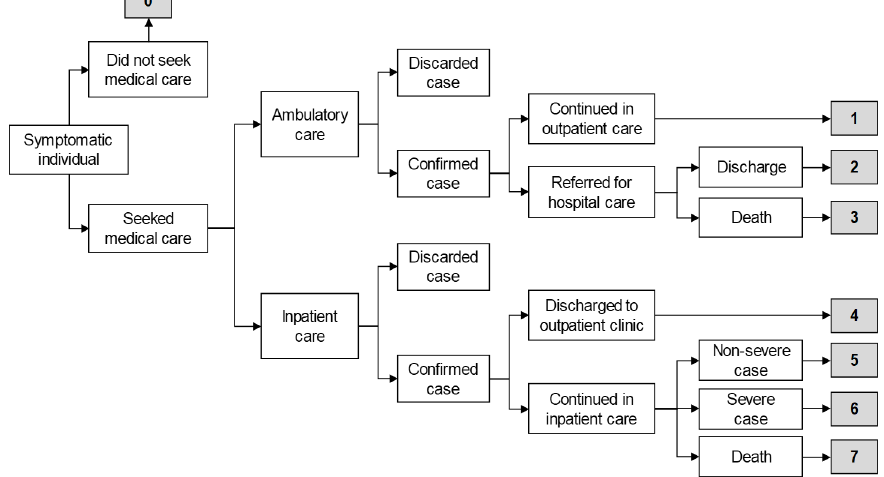
Figure 1. Decision tree for case classification [29]. For details see section: 2.1 Case Classifications . Table 1 details the assumptions made for clinical management of cases for each sce- nario; they were defined according to the National Clinical Guidelines for the Prevention, Diagnosis, and Treatment of Seasonal Influenza in Mexico, as follows [30]: Table 1. Clinical management by scenarios. No Medical Care X 1 Data represent the number of consultations. 2 Data represent the number of prescriptions, units purchased (over-the- counter medications), or culture tests ordered. 3 Estimation of the indicator (years of life lost) applies only to the popula- tions in the scenarios indicated by X. Abbreviations: ER, emergency room; PCR, polymerase chain reaction. 2.2. Laboratory Diagnosis Confirmation of influenza is based on real-time PCR results. In ambulatory care, sam- ple collection for confirmation is required for only 10% of cases, whereas 100% of cases are mandated for sample collection for confirmation of influenza in inpatient care [28]. Throat swab culture is recommended for cases with suspected bacterial coinfection.